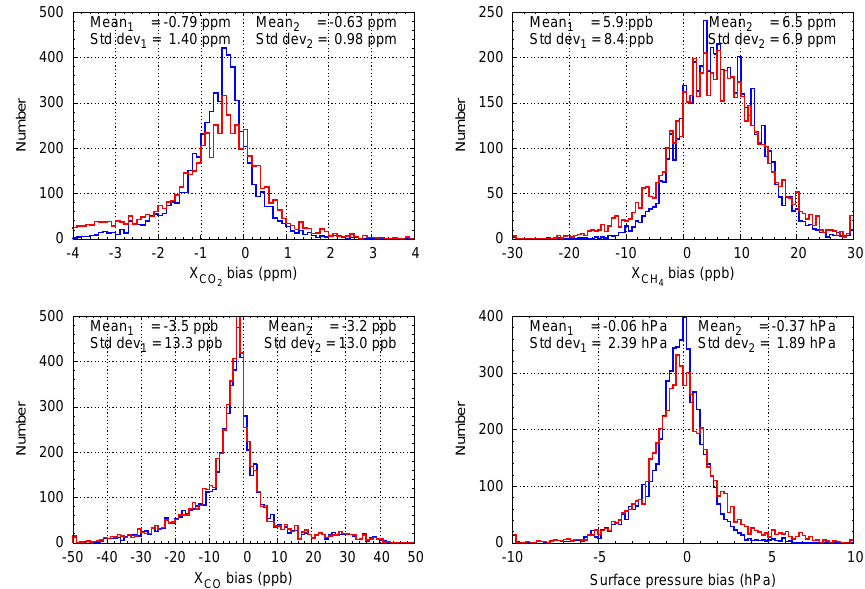
Figure 10. Histograms of the biases in X CO blue histograms apply to Experiments 1 and 2, respectively.